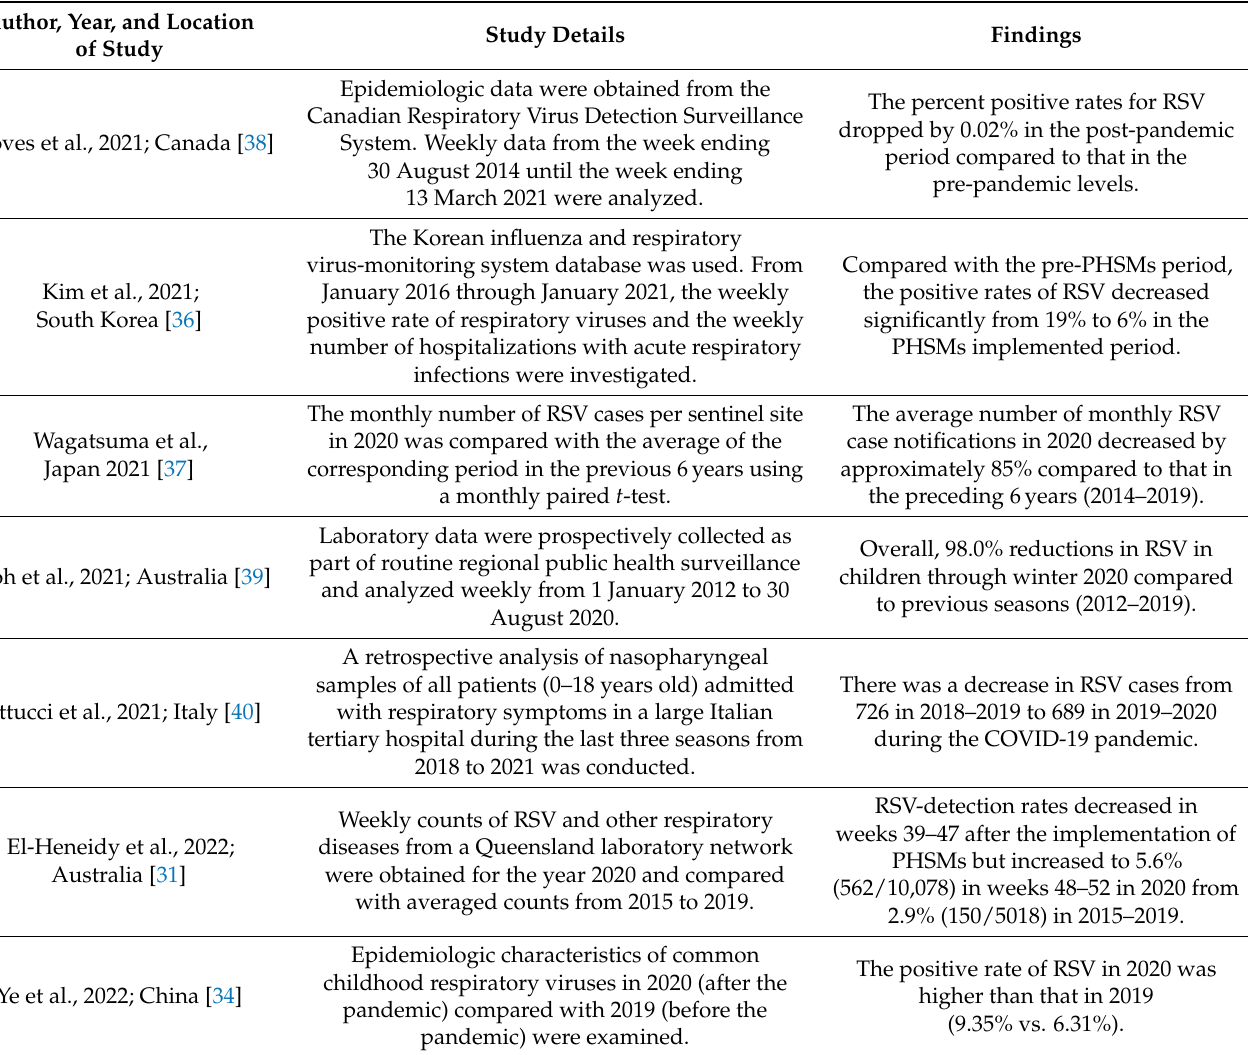
Table 3. Summary of RSV-related articles included in the systematic literature review.